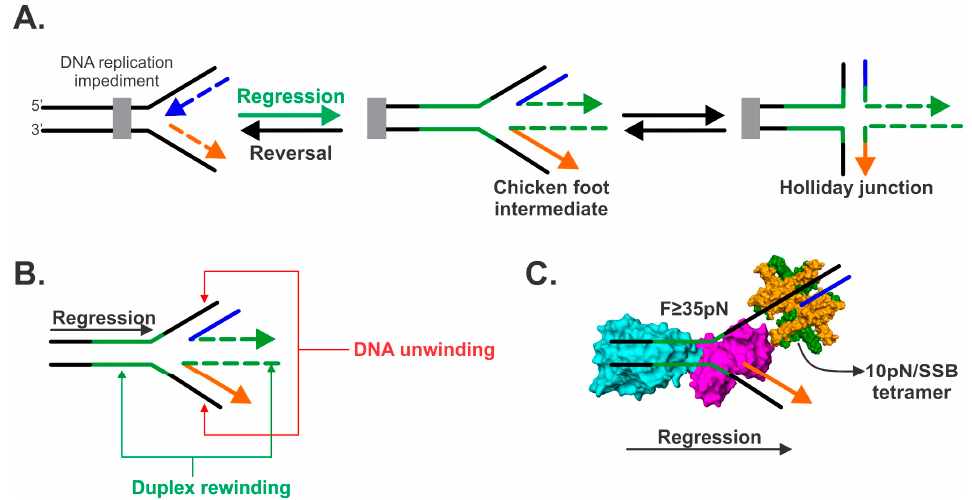
Figure 1. Fork regression. ( A ). Fork regression occurs in a direction opposite to that of DNA replication. An impeded fork is shown with the nascent leading and lagging strands colored blue and orange, respectively. Fork regression involves unwinding of these nascent duplex regions, concomitant with the extrusion of two duplex regions colored in green. The resulting DNA structure is known as the “chicken foot” and is structurally similar to a Holliday junction. Fork reversal (indicated by the balck arrow) results in leftward movement of the fork and an occur only once regression and subsequent impediment repair have taken palce. ( B ). Fork regression requires that DNA unwinding be coupled to duplex rewinding. ( C ). The RecG DNA helicase is shown in the process of fork regression where it couples DNA unwinding to duplex rewinding and displacement of the single-strand binding protein (SSB) protein. RecG and SSB are represented as Connolly surfaces. The wedge domain of RecG is colored purple and the helicase domains in cyan. SSB monomers are colored orange and green.